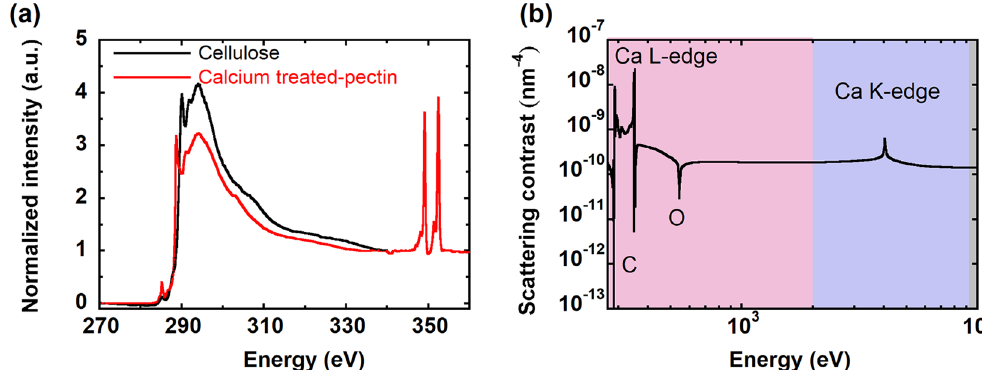
Figure 4. ( a ) Experimentally measured NEXAFS spectra of cellulose (previously reported 64 ) and calcium- treated pectin. ( b ) Scattering contrast between cellulose and calcium treated-pectin as a function of energy for soft (pink), tender (purple), and hard (grey)